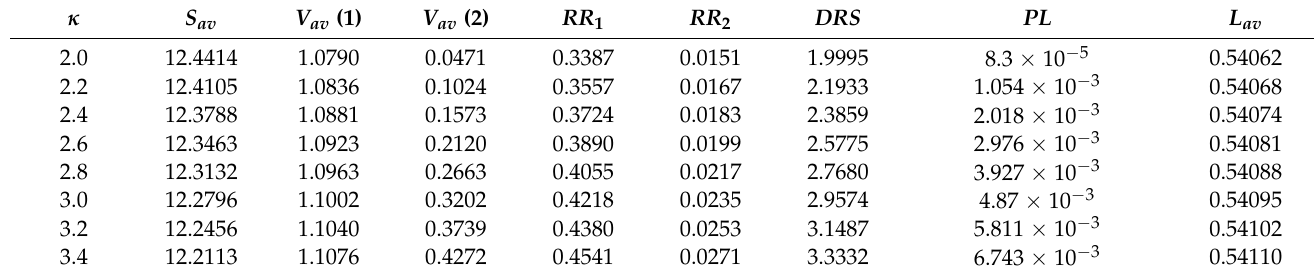
Table 5. Dependence of the performance measures on parameter τ ; λ = 2, µ 1 = 5, µ 2 = 6, κ = 2,